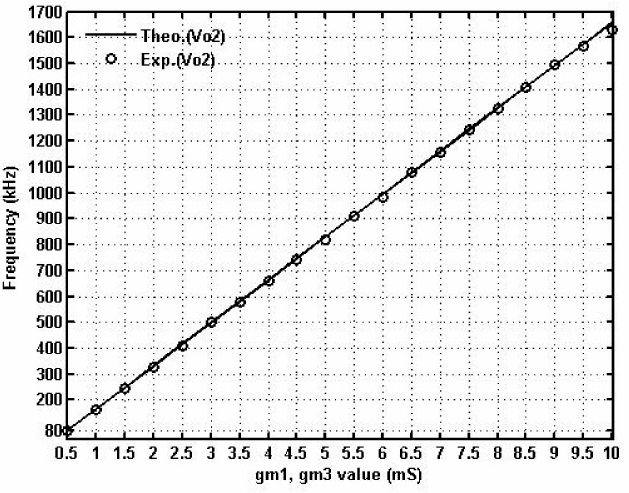
Figure 23. The experimental results of V o2 for g m1 = g m3 .